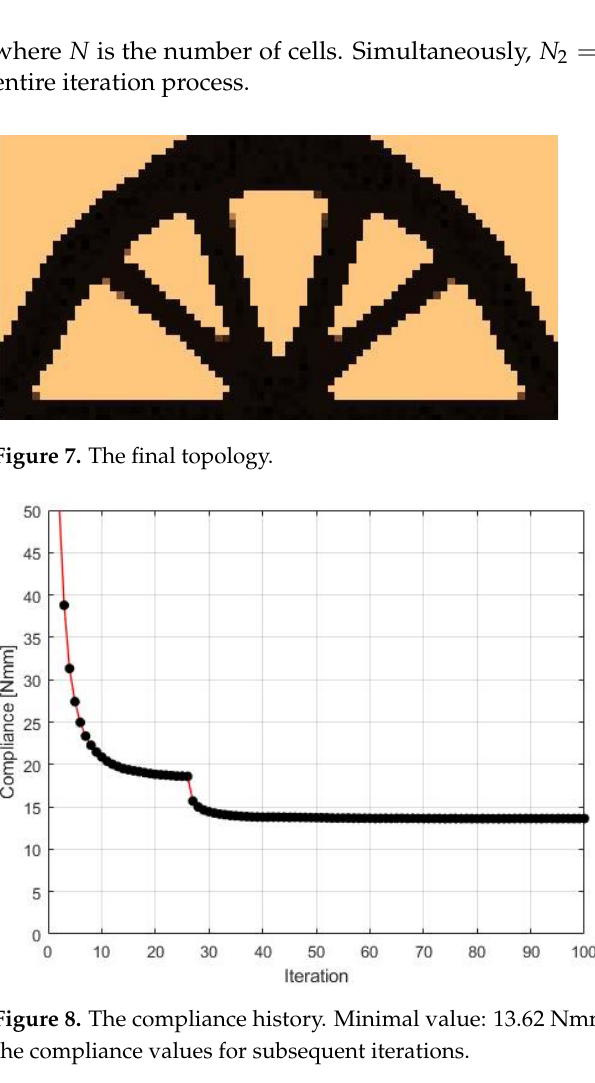
Figure 6. The rectangular structure with applied load and support.